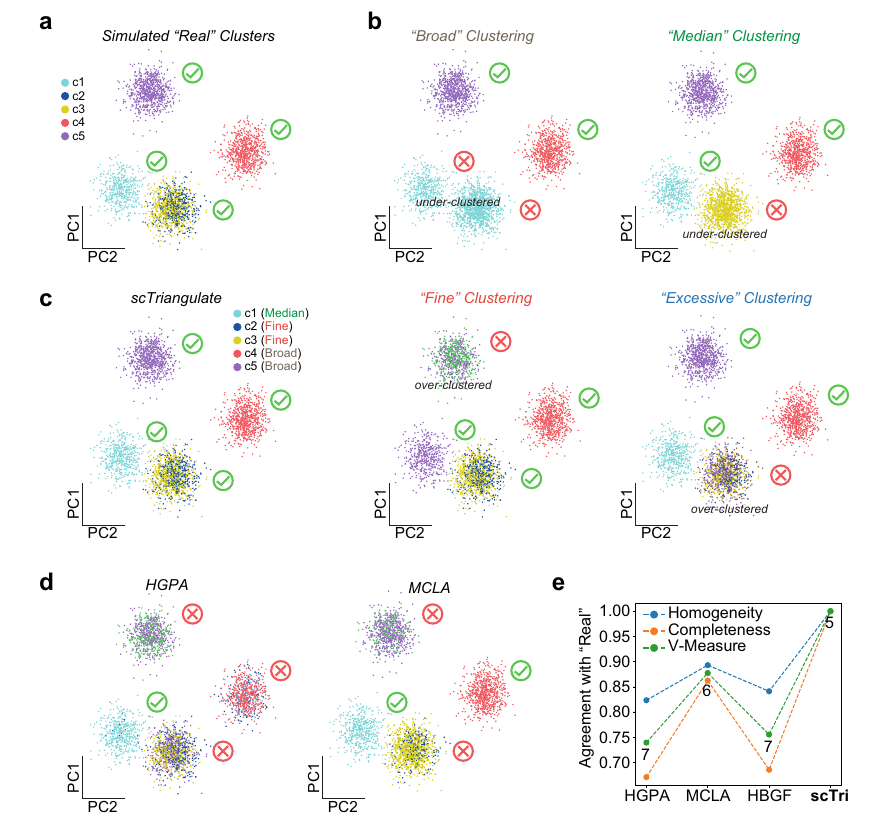
Fig. 2 | Heterogeneous scRNA-Seq clusters are uniquely de fi ned by scTriangu- late. a As a ground-state truth to assess the speci fi city of predictions by scTrian- gulate, we simulated scRNA-Seq data for three highly distinct simulated populations (c1, c4, and c5) and two subtly different subclusters (c2 and c3) (Methods). b To predict suchclusters, we producefour cluster annotations for the same cells in panel ( a ), with different granular cluster de fi nitions (broad, median, fi ne, and excessive). These include the noted under-clustered and over-clustered populations, which are not supported by gene expression differences. No indivi- dual resolution intentionally mirrors ground-state truth. Green checkmark=